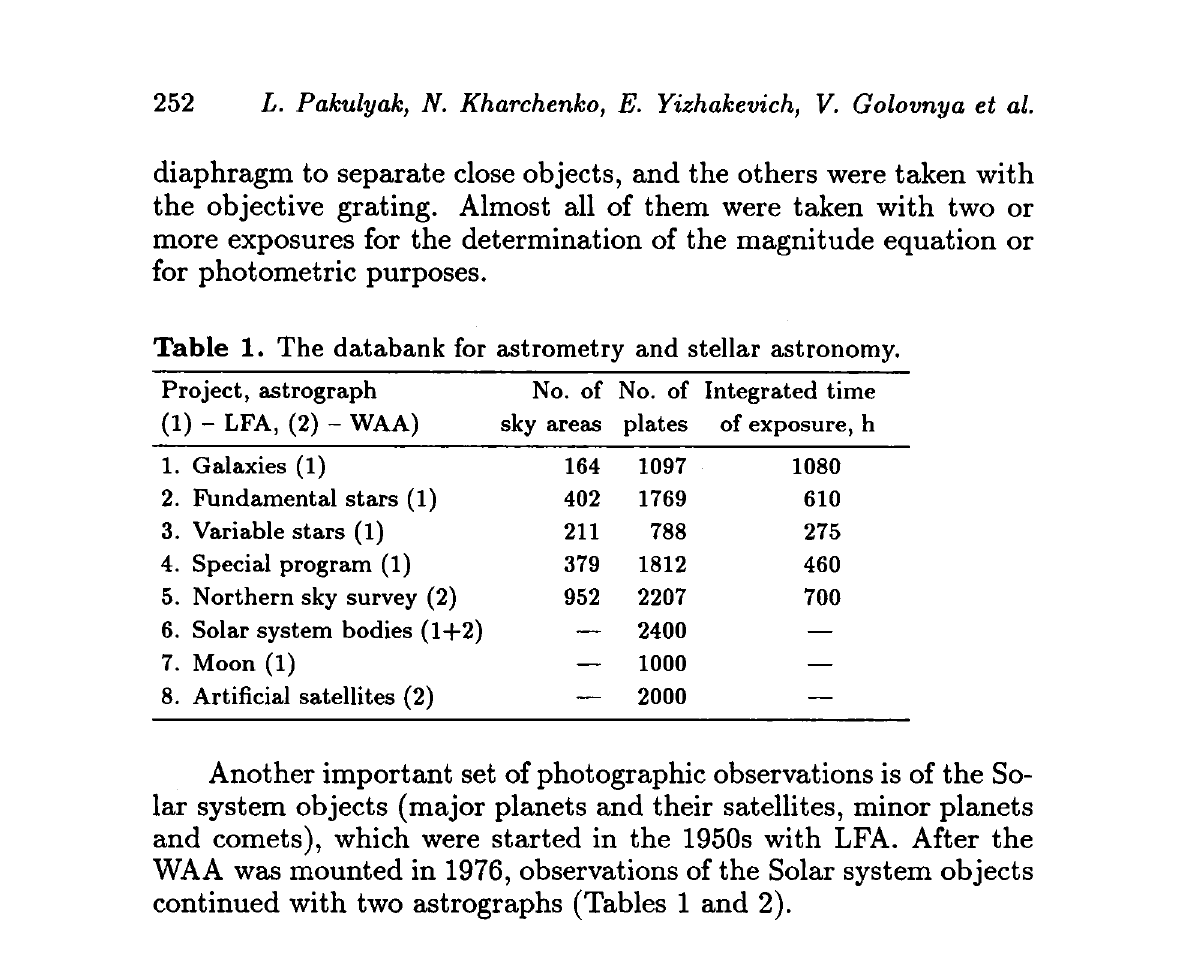
Table 2. The distribution of the plates by the year. Project /'Year